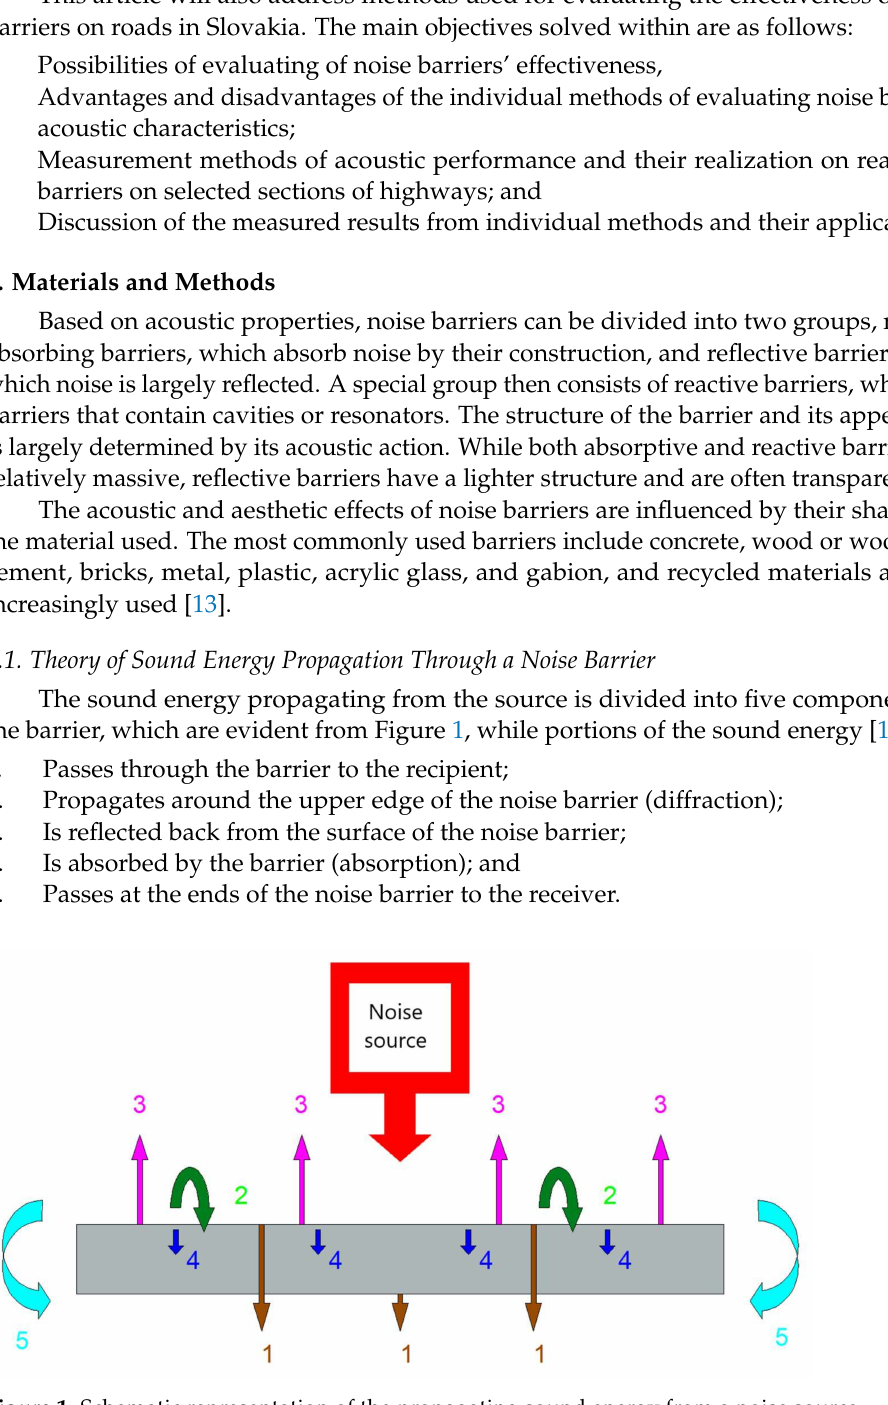
Figure 1. Schematic representation of the propagating sound energy from a noise